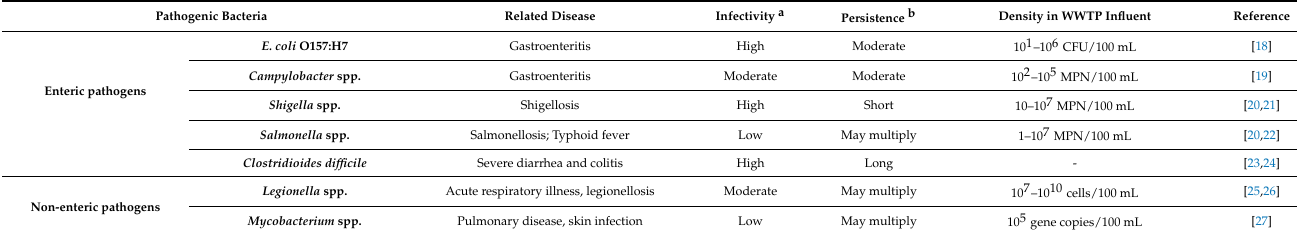
Table 1. Pathogenic bacteria detected in wastewater with high significance to public